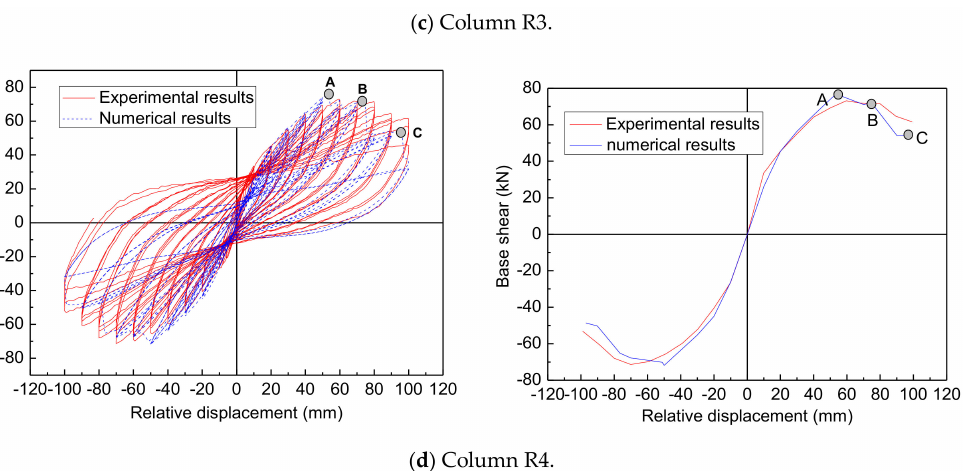
Figure 13. The hysteretic curves for repaired columns: ( a ) Column R1; ( b ) Column R2; ( c ) Column R3; ( d ) Column R4.